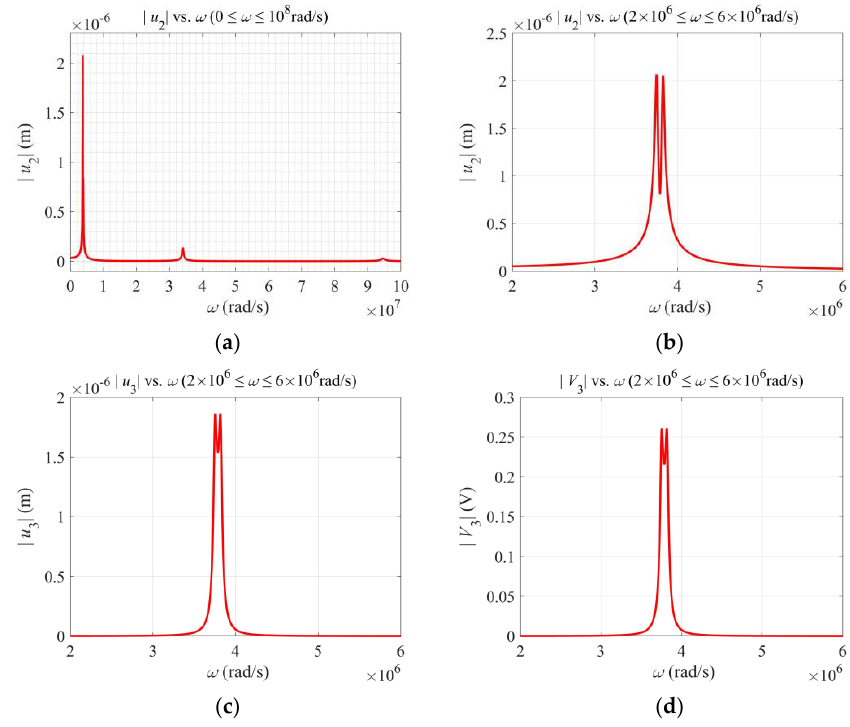
Figure 2. Behavior near the first resonance. ( a ) Primary motion showing resonances. ( b ) Primary motion near the first resonance. ( c ) Secondary motion near the first resonance. ( d ) Output voltage near the first resonance.